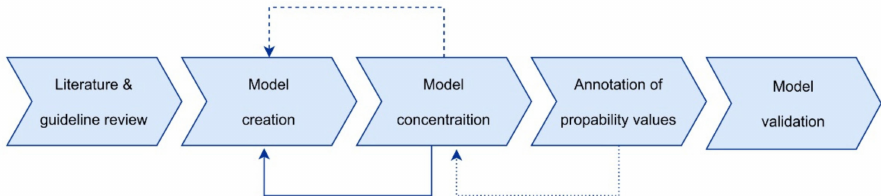
Figure 1. The initial literature research on HNSCC, ICB, and potential future targets of ICB led to a first graph model with more than 290 nodes. The input of regular expert meetings (depicted by the dashed arrow) and visits of the university hospital’s tumor board (depicted by the drawn trough arrow) were integrated into the model development process. After step-by-step adoption of the model (with regular meetings, depicted by the dotted line), we finalized the model for validation